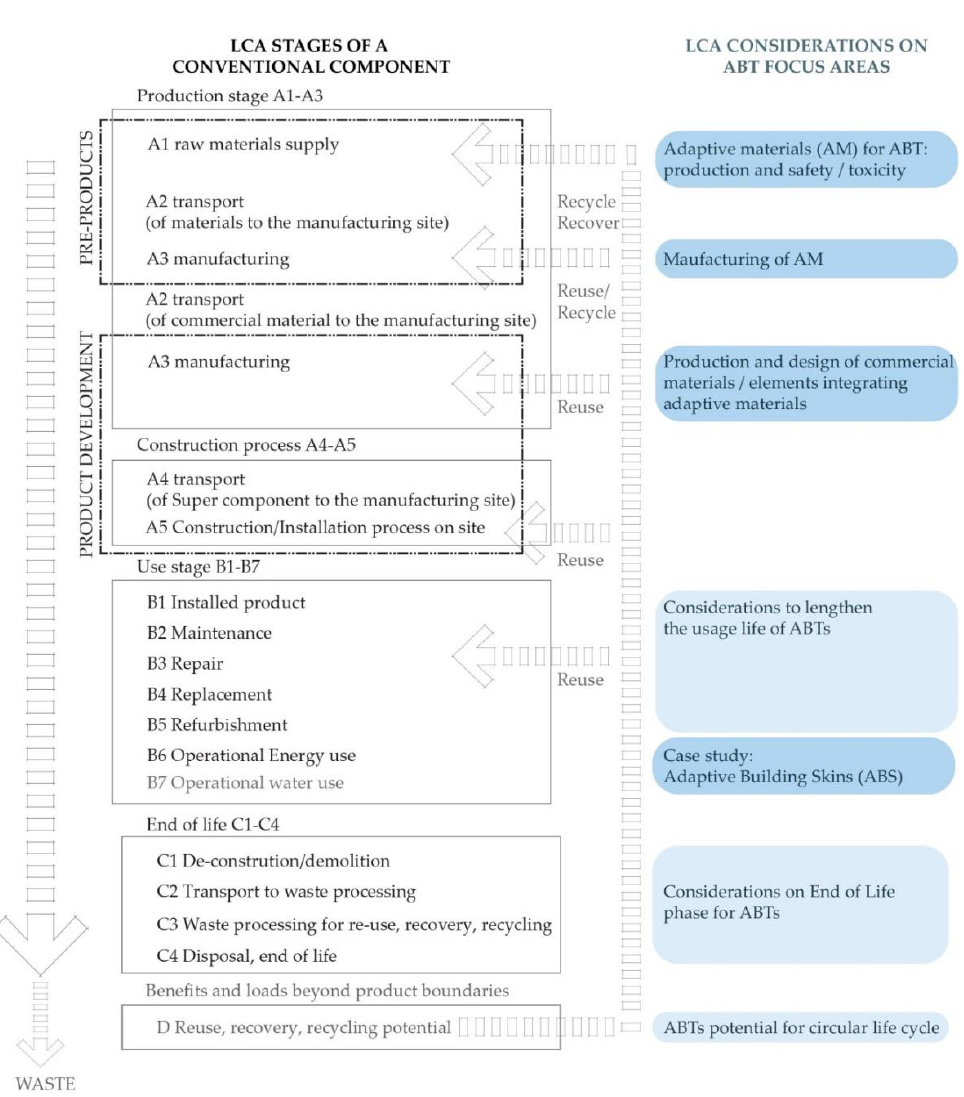
Figure 3 identifies the main areas of study: highlighted in dark blue, the phases where ABTs’ LCA di ff ers from a traditional LCA; and in light blue, those impacted by the design choices made in earlier life cycle stages.